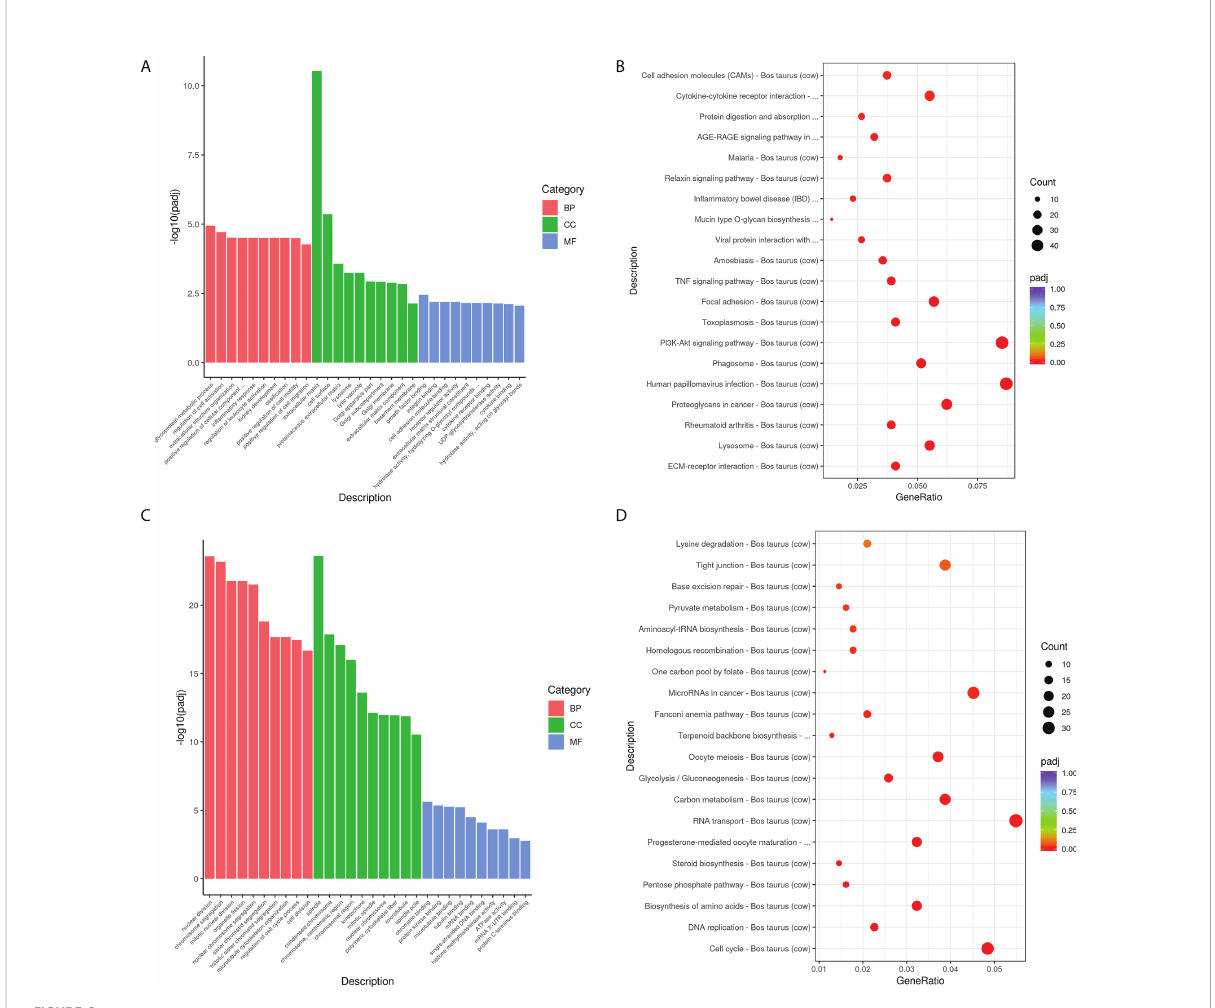
FIGURE 6 Biological function analysis of DEGs using GO and KEGG enrichment analysis. (A) The top 10 GO terms enriched for the upregulated DEGs. The Y-axis represents the number of -log10(padj), and the X-axis represents GO terms. All GO terms are classi fi ed into three ontologies: red denotes a biological process (BP), green denotes a cellular component (CC), and blue denotes a molecular function (MF). (B) The top 30 KEGG pathways that are enriched in the upregulated genes. The vertical axis represents the pathway name, the horizontal axis represents the Gene ratio, the size of the dots indicates the number of candidate target genes in this pathway, and the color of the dots corresponds to the different padj . (C) The top 10 GO terms enriched for the downregulated DEGs. (D) The top 30 KEGG pathways enriched in the downregulated